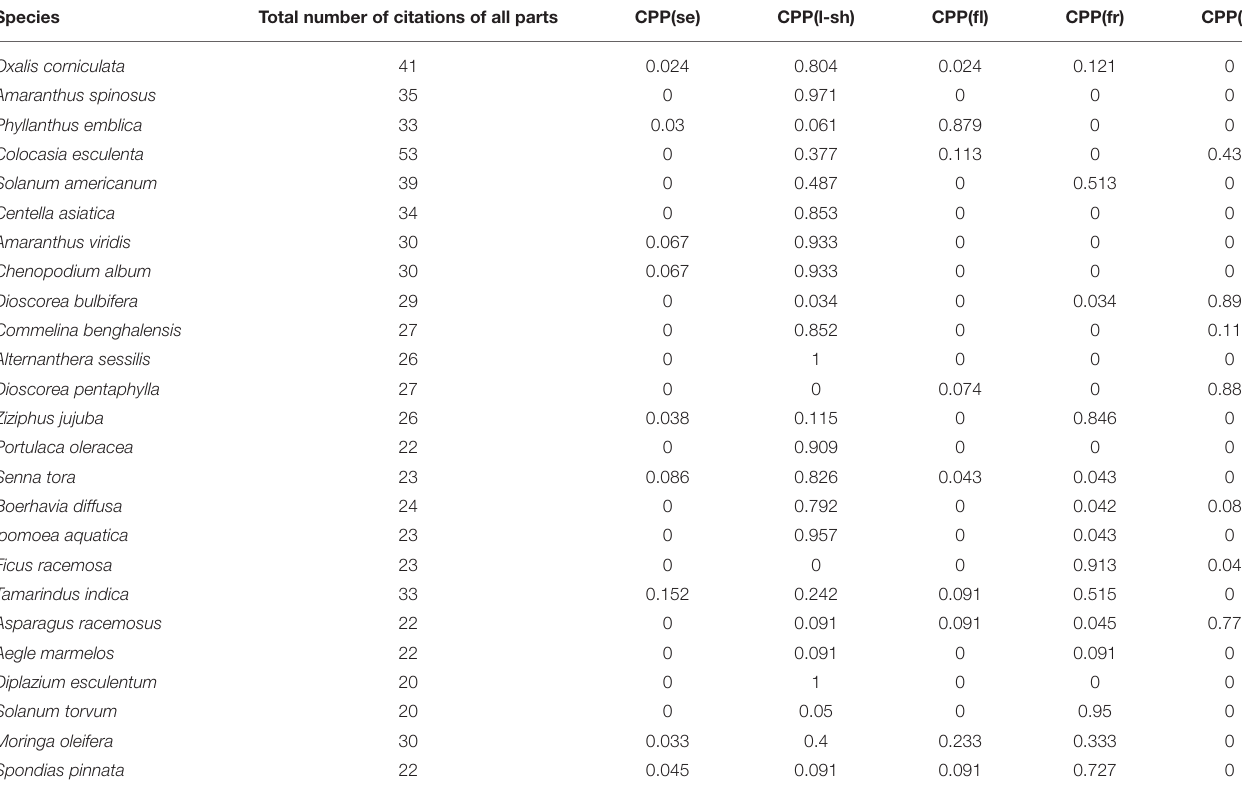
TABLE 4A | CPP value for selected plants with highest RFC value. Species Total number of citations of all